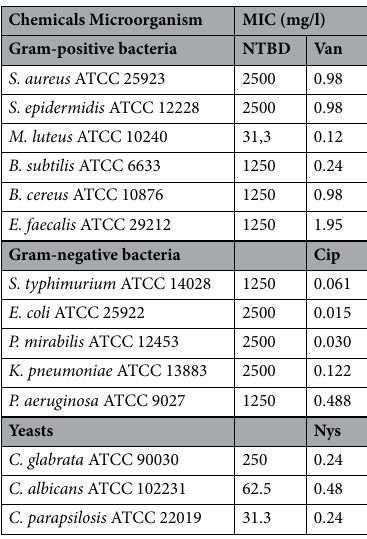
Table 4. Antibacterial and antifungal activities of NTBD presented in minimal inhibitory concentration (MIC) values. Van vancomycin, Cip ciprofloxacin, Nys